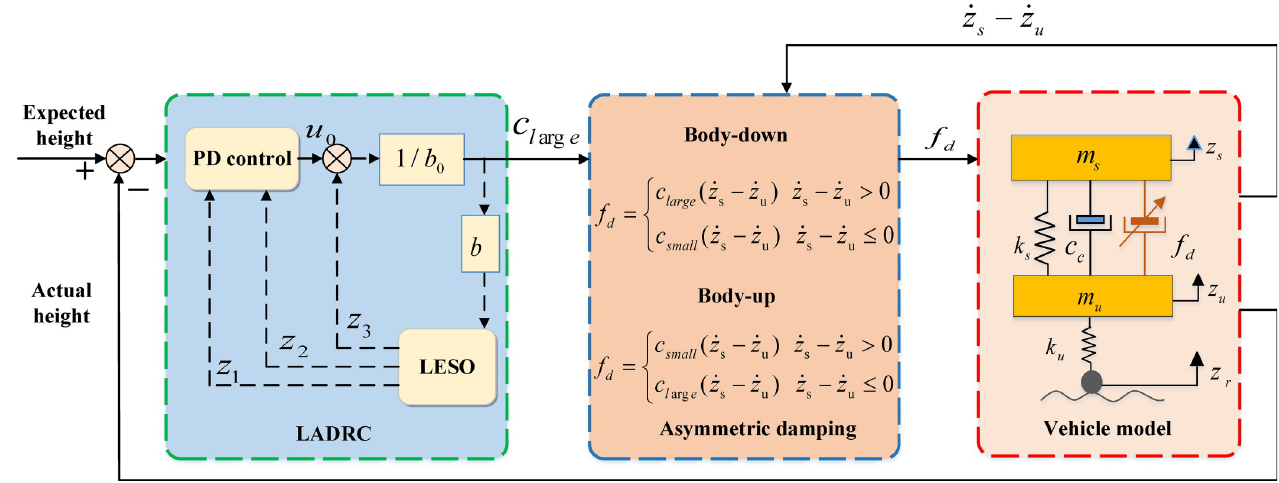
Fig 13. Schematic diagram of the vehicle height